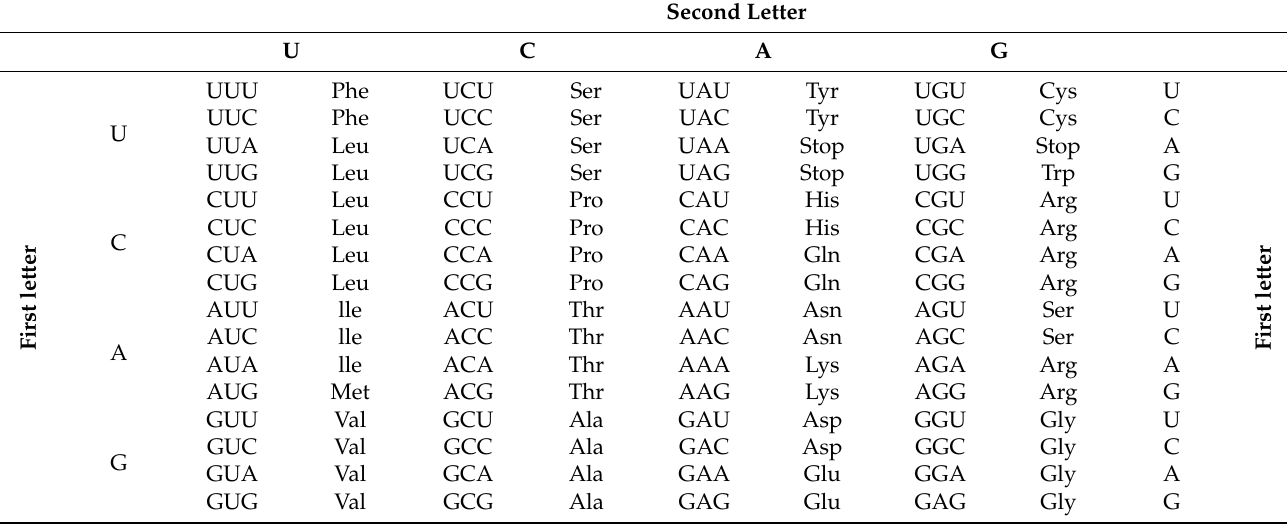
Table 1. Formation of mRNA codons and their relevant protein representations